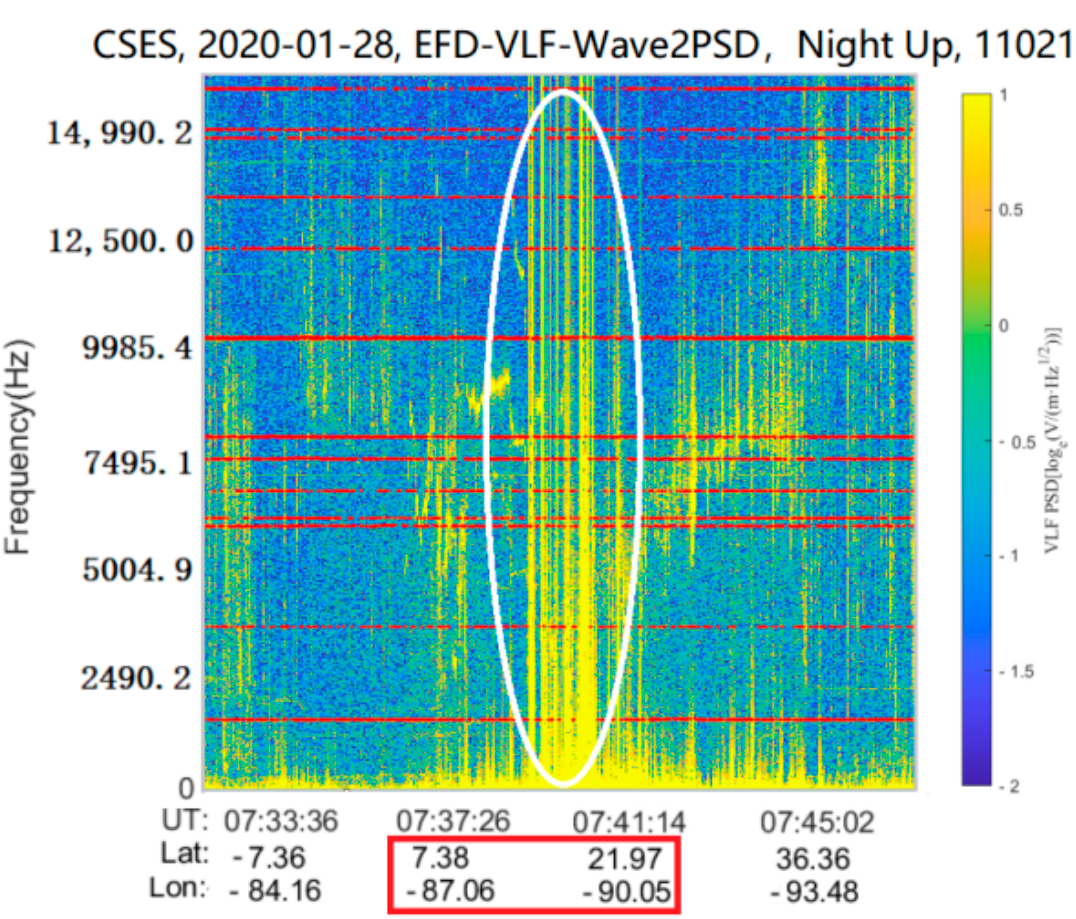
Figure 12. Automatic detection and labeling